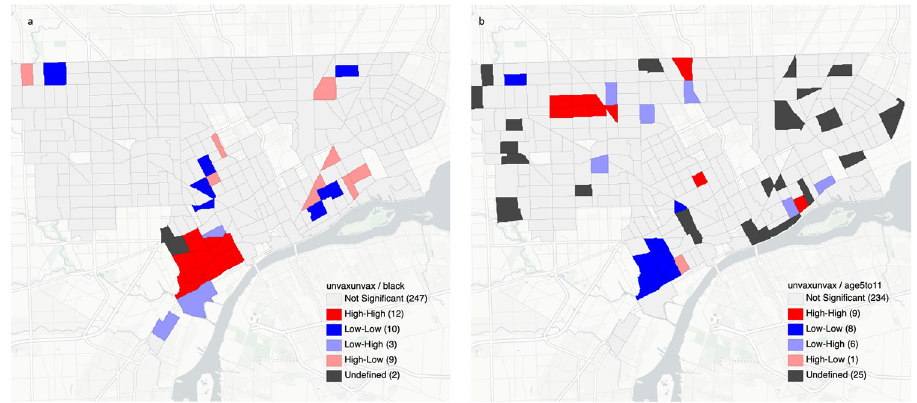
Fig 3. Hotspot clusters of unvaccinated patients who were Black or African American (a) or age 5–11 years (b). Clusters are categorized as high-high cluster (red), low-low cluster (blue), low-high outlier (light blue), and high-low outlier (light